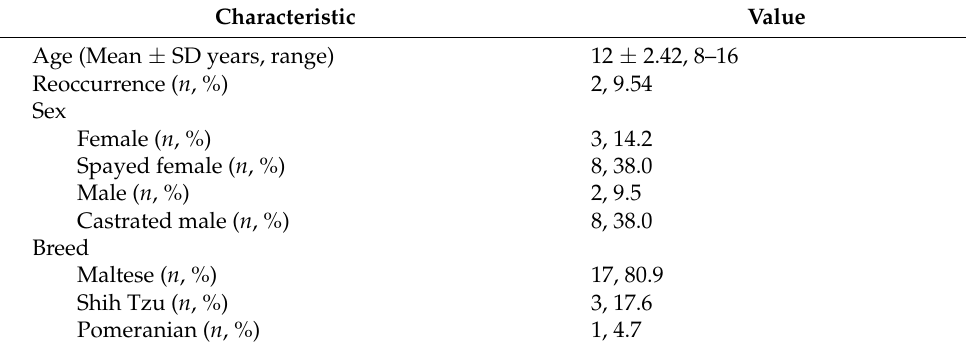
Table 1. Signalment of MMVD dogs with CPE ( n = 29).